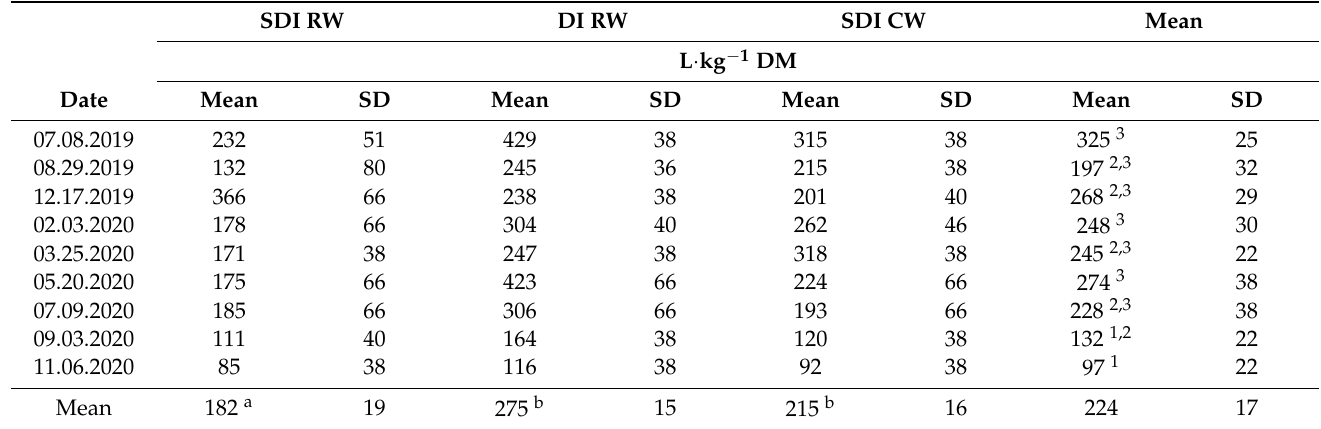
Table 8. Irrigation water use efficiency (WUE) obtained per harvest and treatment. SDI RW DI RW SDI CW